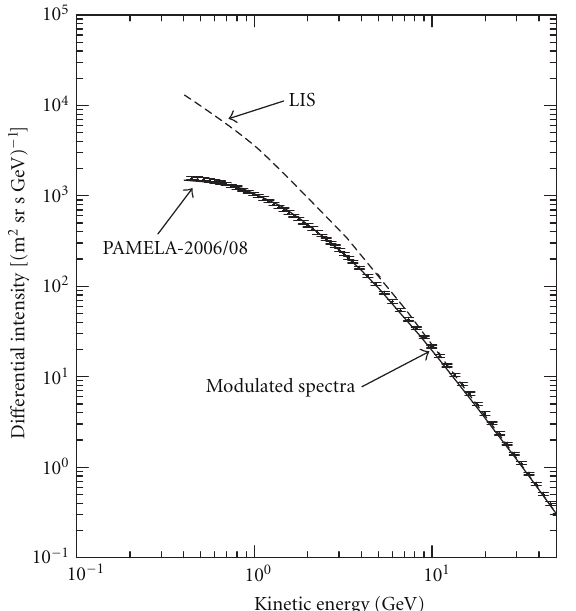
F 6: Proton differential intensity determined with the HelMod code (continuous line) compared to the experimental data of PAMELA 2006/08; the dashed line is the LIS (see the text).